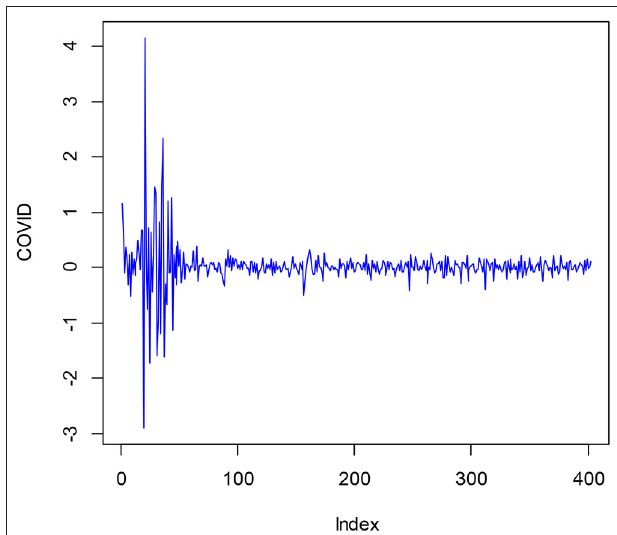
FIGURE 3 | Daily tests data after stationarity.